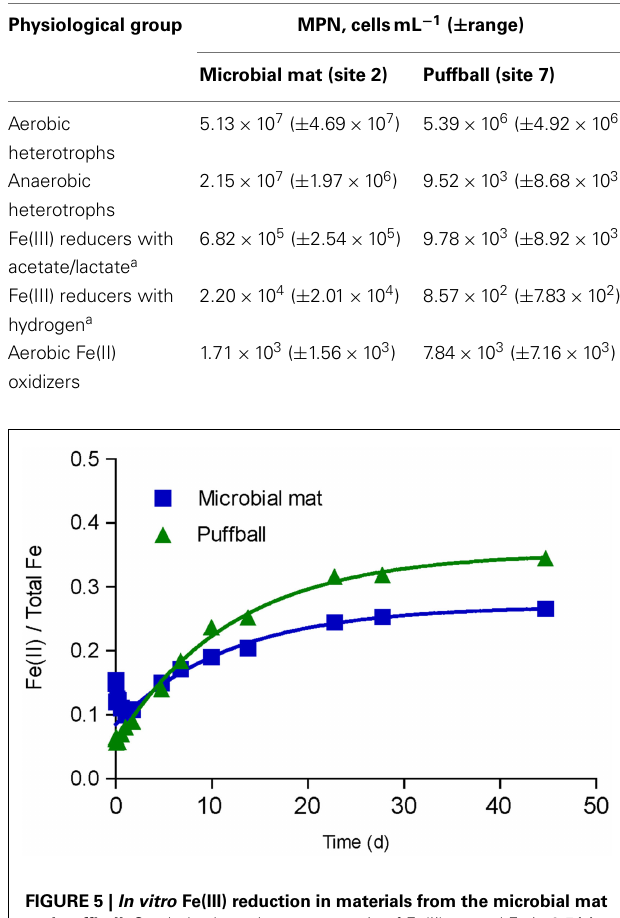
FIGURE 5 | In vitro Fe(III) reduction in materials from the microbial mat and puffball. Symbols show the average ratio of Fe(II) to total Fe in 0.5M HCl extracts from duplicate cultures; lines show results of non-linear least-squares regression fits of the Fe(II) accumulation data to an integrated first-order rate law Fe(II) t = Fe(II) 0 + [Fe(II) max − Fe(II) 0 ] × [1 − exp(-k red t)]. Estimated k red values were 0.085 and 0.083day − 1 for the microbial mat and puffball materials,